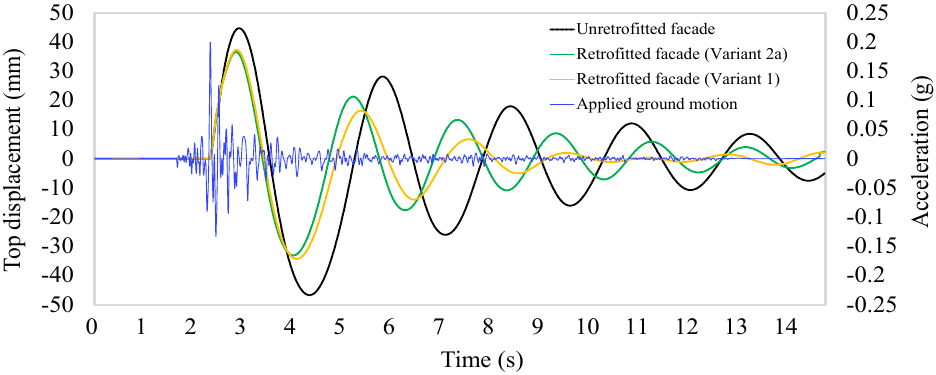
Figure 8. Displacement time history response of the unretrofitted and retrofitted facade (Variants 1 and 2a) subjected to the ground motion recorded at the 1974 Imotski earthquake (No 5 in Table 2) with PGA = 0.2 g.